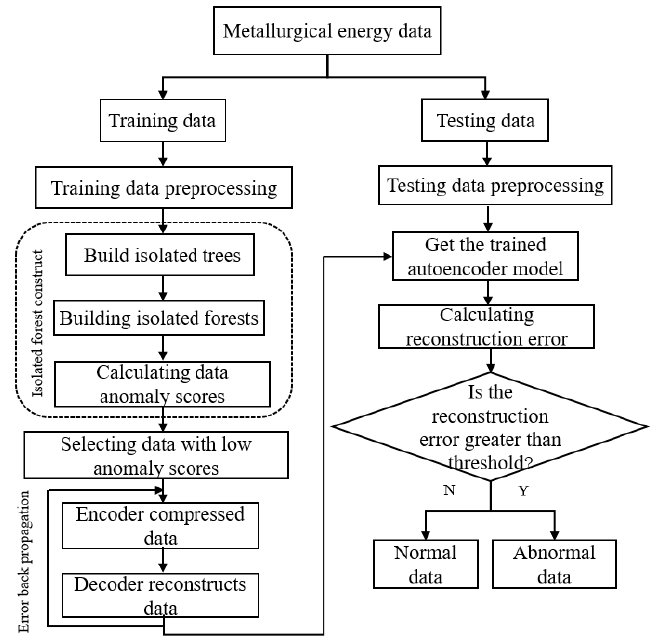
Figure 1. The anomaly detection process based on the AE-iForest.